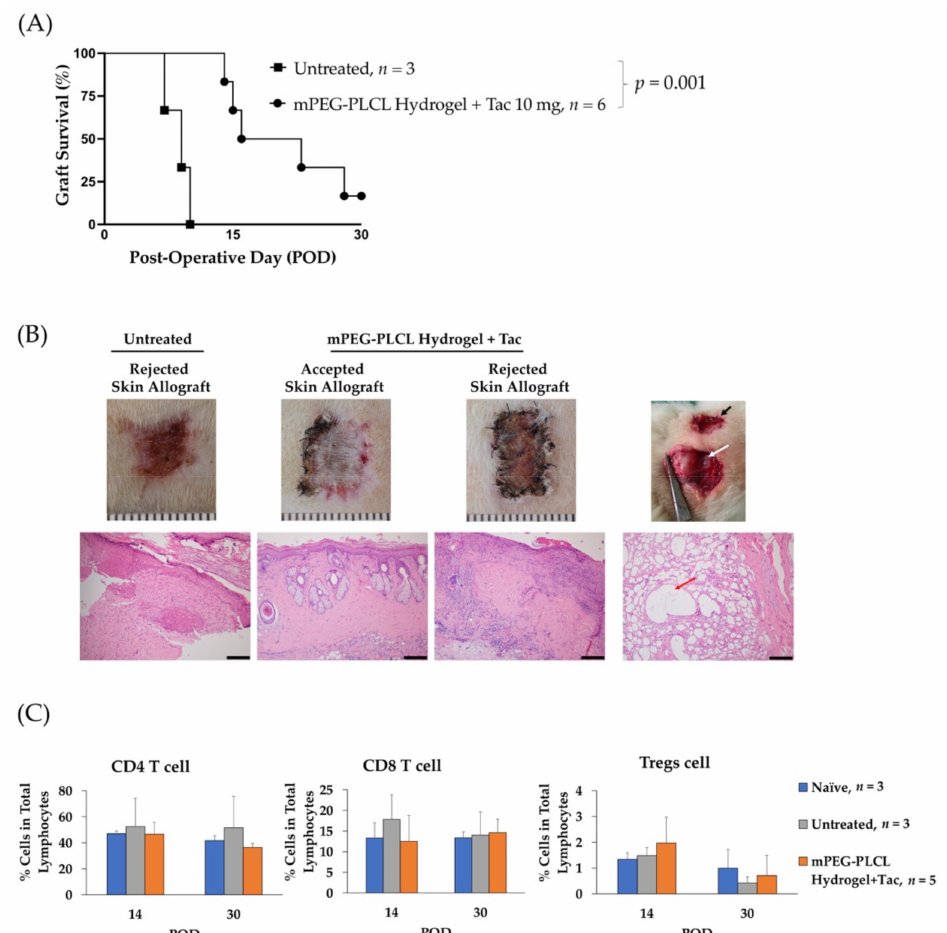
Figure 5. mPEG-PLCL hydrogel injection prolonged skin allograft on Lewis Rats. ( A ) Graft survival rate. ( B ) Macroscopic and microscopic view of skin allograft and tissue surrounded hydrogel. The black arrow indicates the location of the skin allograft. The white and red arrows indicate degraded hydrogel. Magnification: 100 × , Scale bar: 200 µ m ( C ) Peripheral blood (CD4 T cell, CD8 T cell and regulatory T cell) quantitative analysis. The Naïve and Untreated represent the level of peripheral blood from Lewis rats without transplantation and which received transplantation without hydrogel injection,